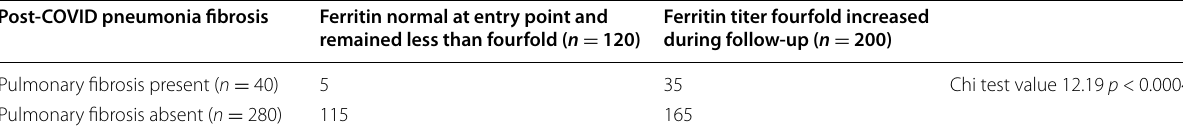
Table 8 Normal ferritin level ( n 320) at entry point and follow-up and its correlation with post-COVID lung fibrosis = Post-COVID pneumonia fibrosis Ferritin normal at entry point and remained less than fourfold (